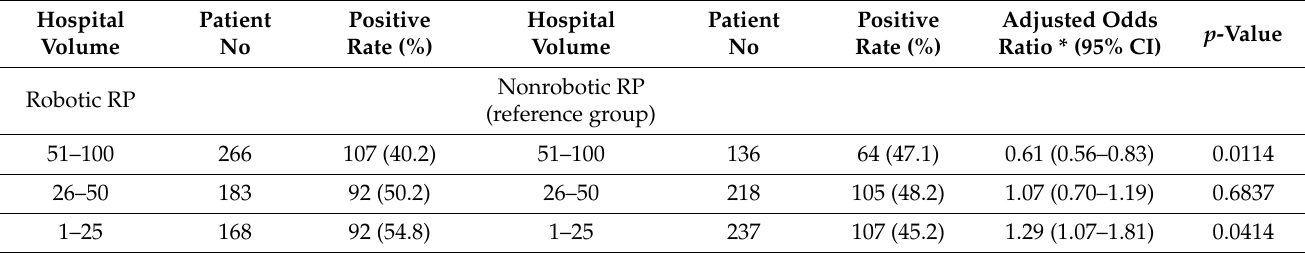
Table 3. Sensitivity analysis of multivariate analysis after propensity scores adjustment using Logistic regression comparing positive surgical margin rates stratified by hospital volume between nonrobotic and robotic radical